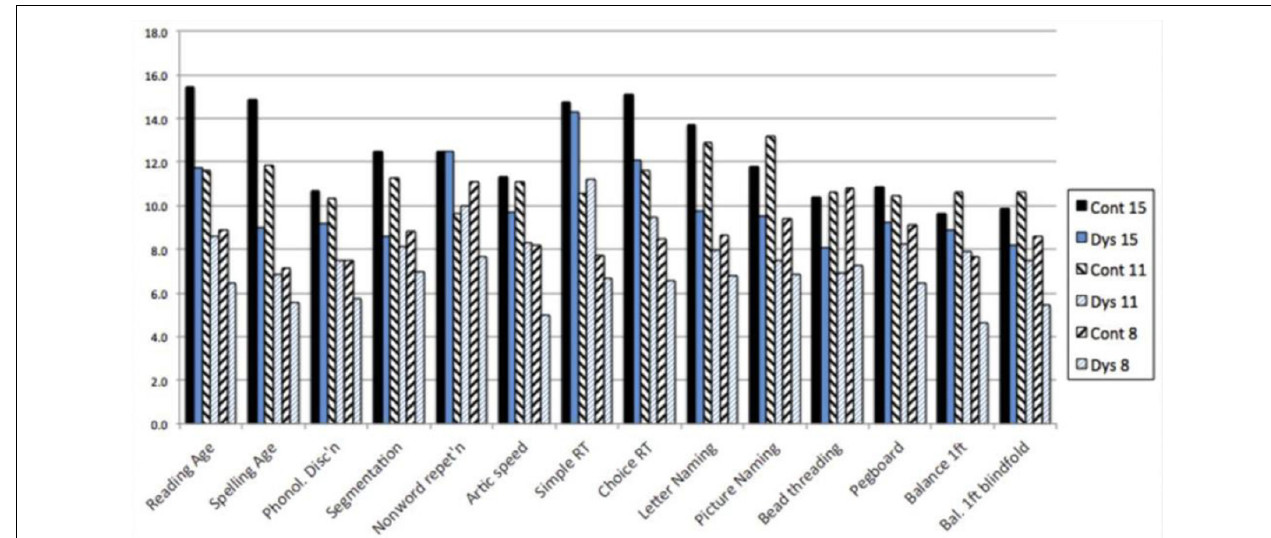
FIGURE 2 | Age-equivalent scores across the range of primitive